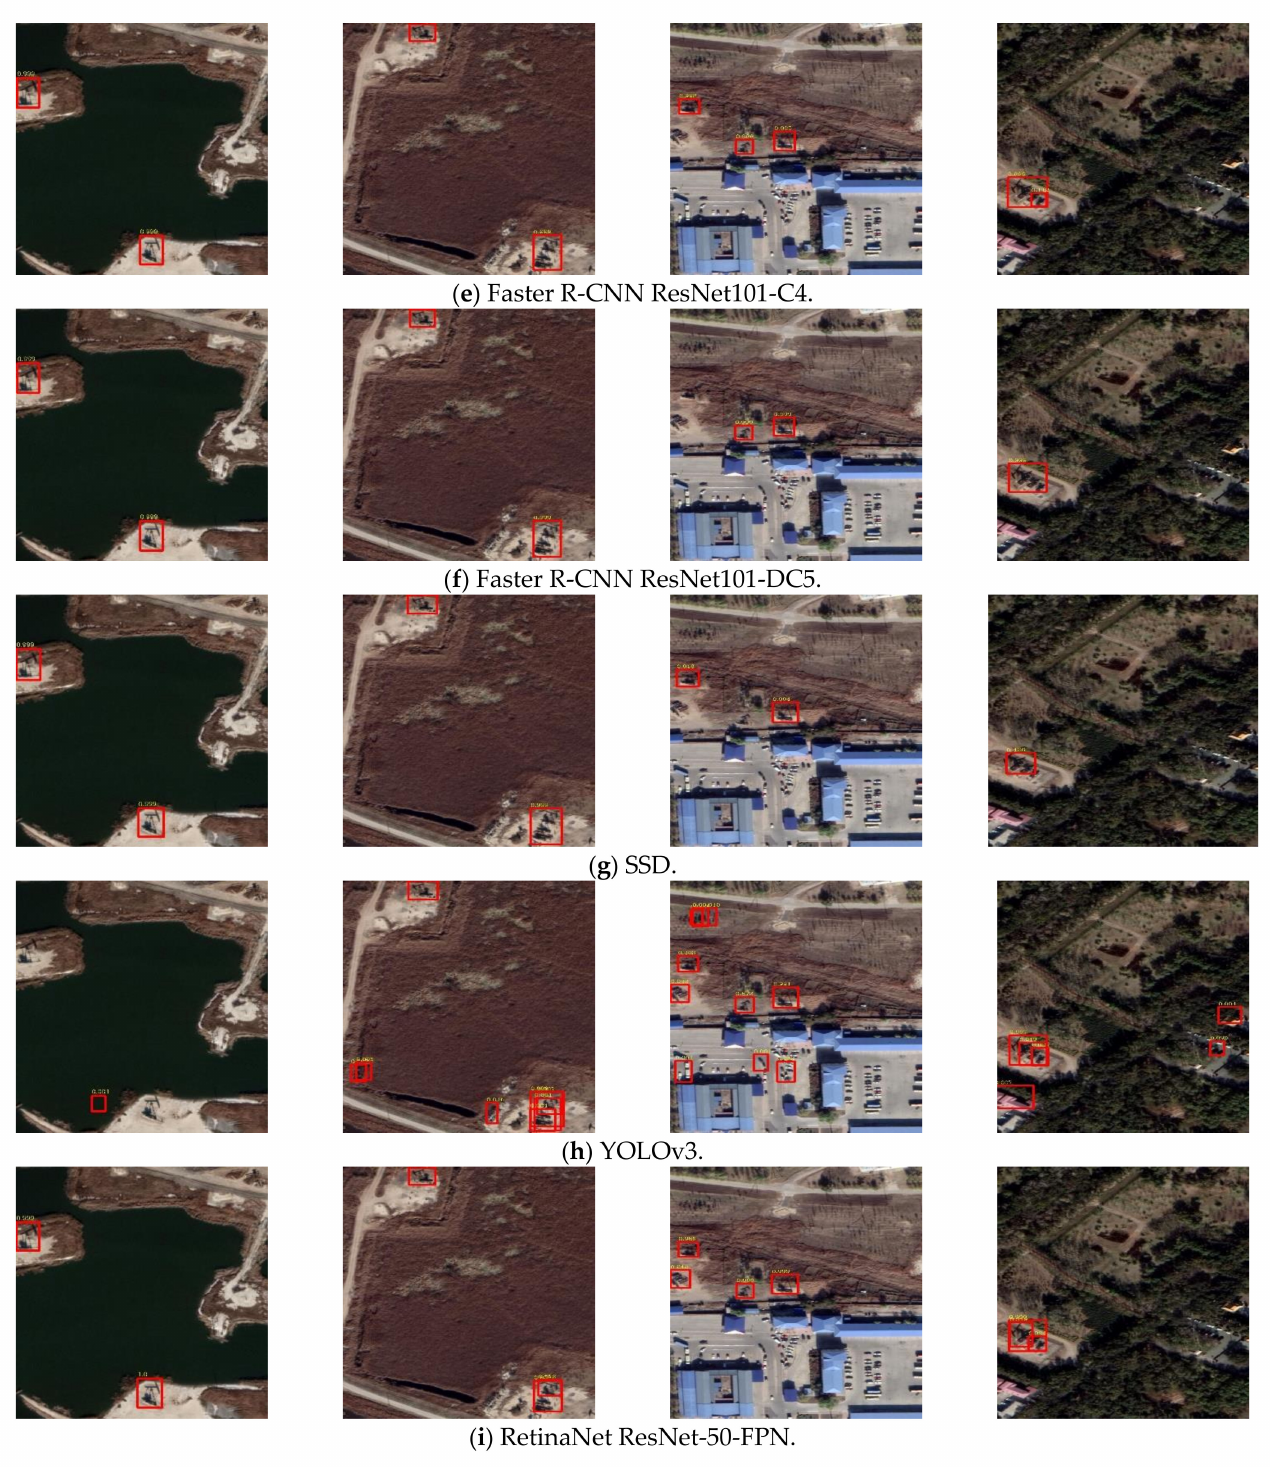
Figure 15. Object detection results of all the state-of-the-art models. The red boxes represent the detected oil wells. Table 4 presents the results of McNemar’s Test in order to explore whether the perfor- mance differences in different models are significant. Most of the Faster R-CNN models and RetinaNet model are statistically similar while Faster R-CNN ResNet50-DC5, SSD, and YOLOv3 show significantly differences with other models in model